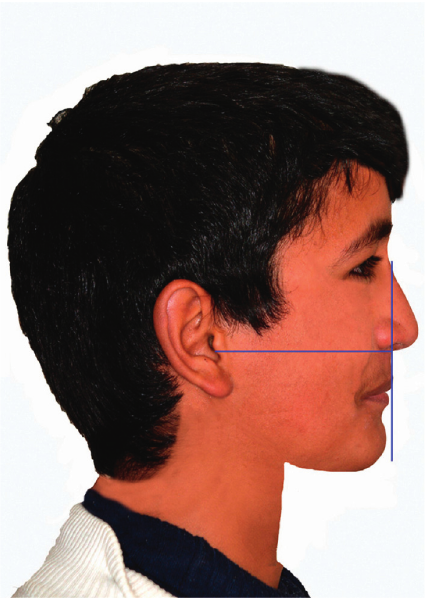
Figure 1: The baseline image used in the study as a reference for each variable with optimum projections of the major lower face profile points to the TVL (vertical and horizontal planes were removed for the rating